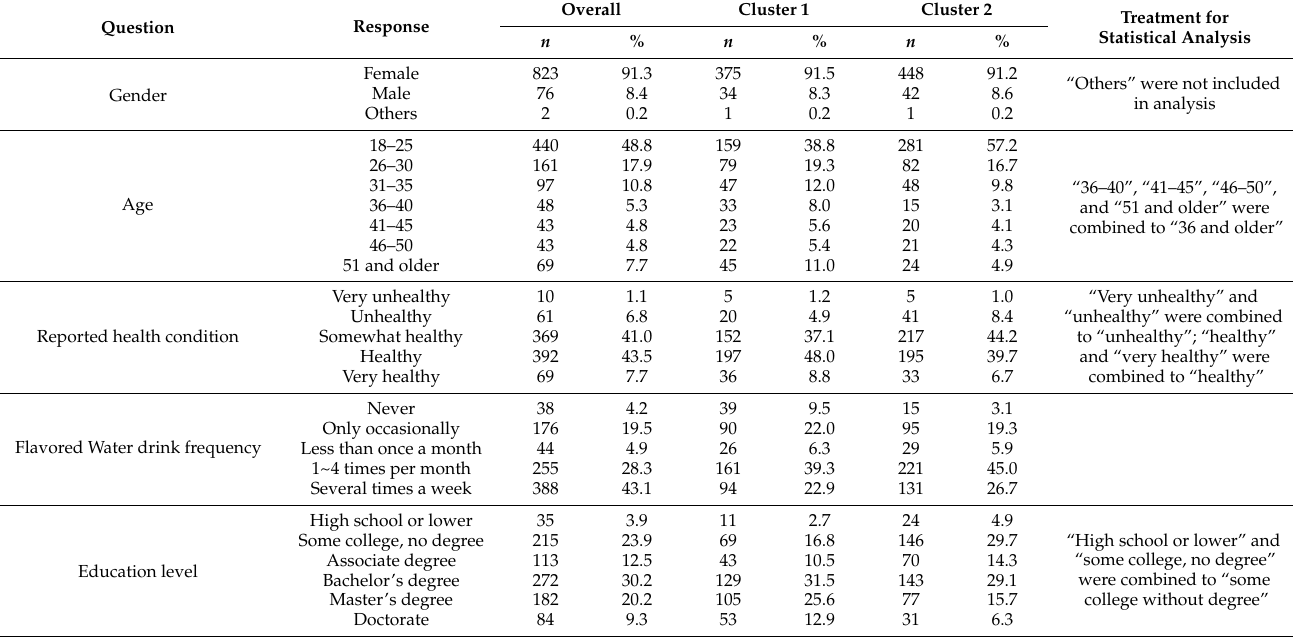
Table 2. Number and percentages on overall sample and by clusters for demographic variables of the